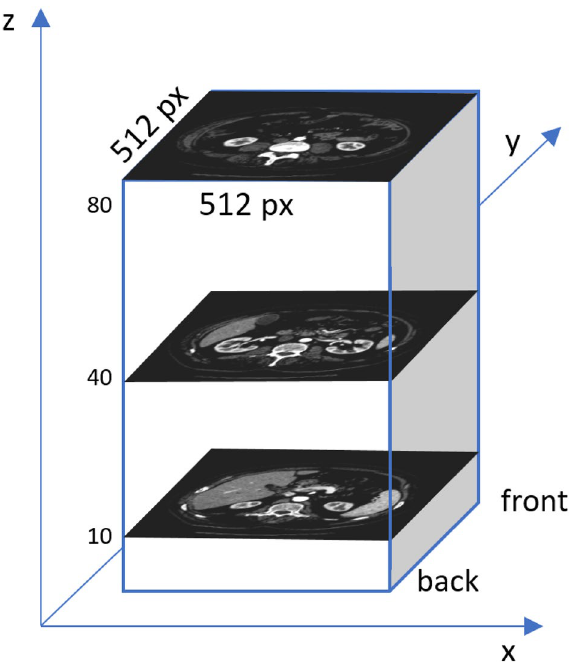
Figure 2. Diagram showing the position of the selected slices with indices 10, 40 and 80 in the volume, together with superimposed X–Y–Z